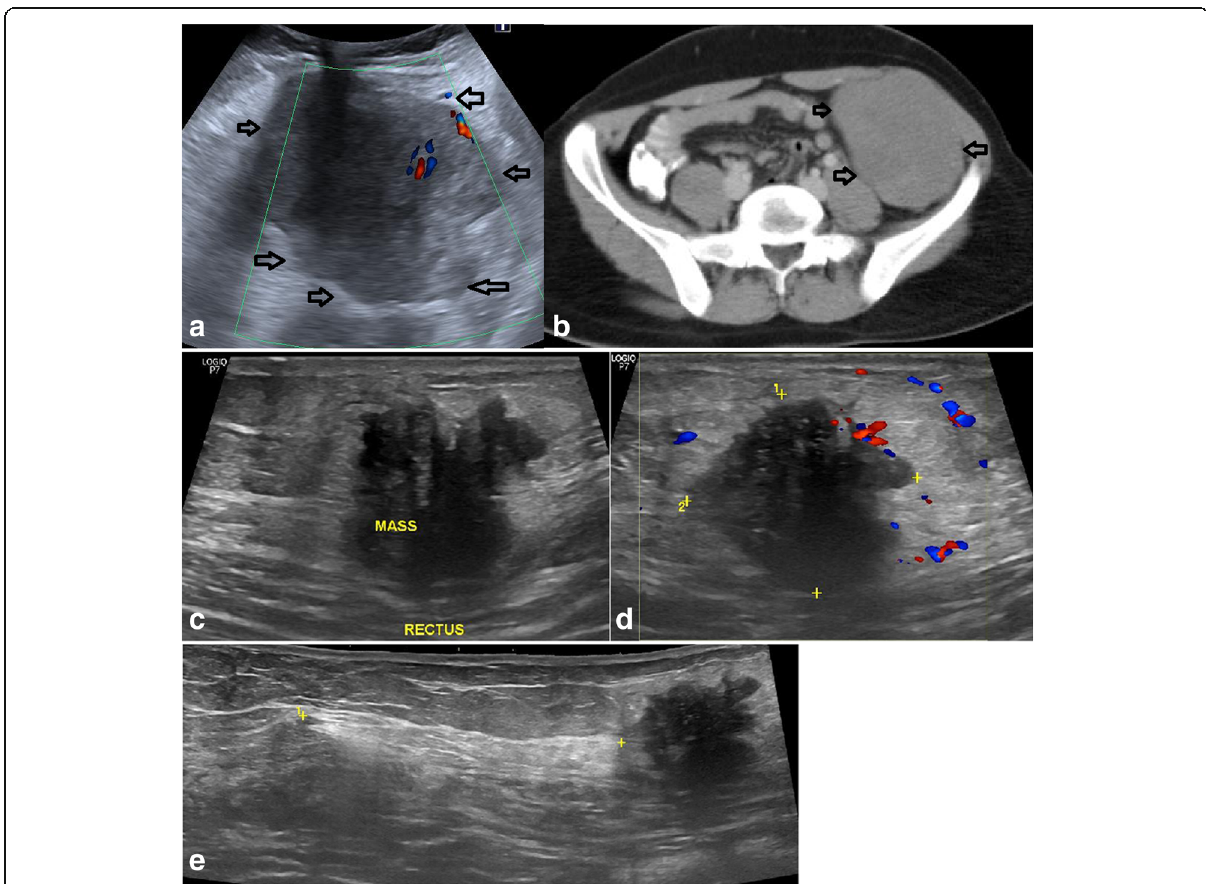
Fig. 7 a A color Doppler image showing a hypoechoic mass lesion infiltrating the abdominal wall muscles (between the open black arrows). b An axial post-contrast CT image of the lower abdomen for the same patient showing an isodense lesion (between the black arrows) infiltrating the left anterior abdominal wall muscles; this was histopathologically proven to be a desmoid tumor. c – e Ultrasound images for another patient with a left rectus abdominus muscle desmoids tumor: c an ultrasound image showing a lobulated hypoechoic lesion infiltrating the left rectus abdominus muscle, d a color Doppler image showing peripheral and peri lesion vascularity, e a panoramic ultrasound view demonstrating the hypoechoic infiltrating lesion infiltrating the lower-left rectus abdominus muscle (between the calibers)